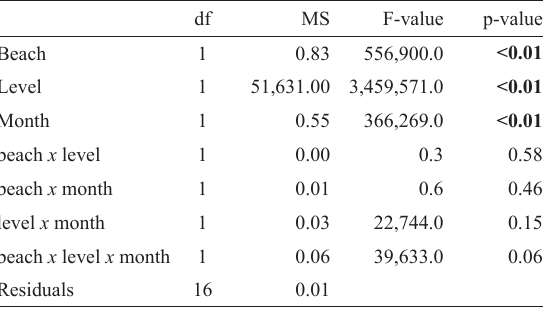
Result of three-way ANOVA for